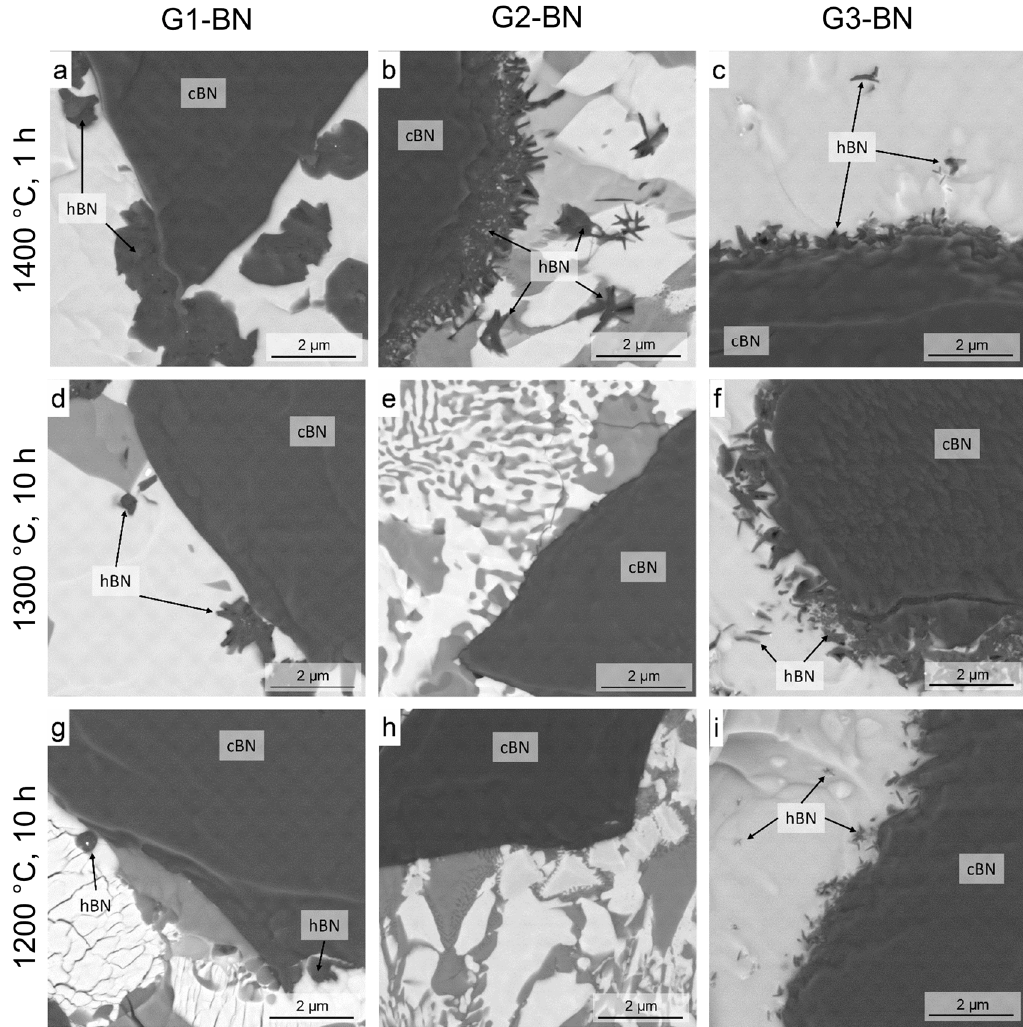
Figure 4. FESEM micrographs of the ion beam polished sections of the glass–c-BN composites heat treated at: ( a – c ): 1400 °C, 1 h; ( d – f ): 1300 °C; 10 h and ( g – i ): 1200 °C, 10 h. From left to right: G1-BN, G2-BN, G3-BN.